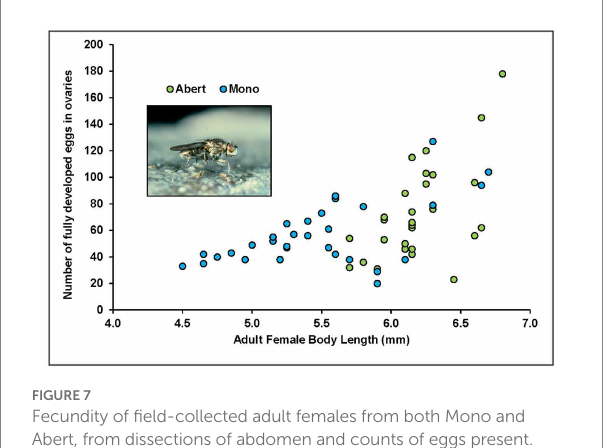
FIGURE 7 Fecundity of field-collected adult females from both Mono and Abert, from dissections of abdomen and counts of eggs present. Abert green points, Mono blue points.